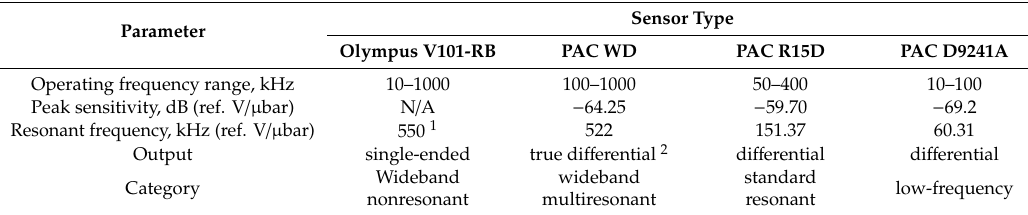
Table 1. Parameters of the AE sensors used to determine the frequency of acoustic signals emitted by PD in oil–paper insulation.